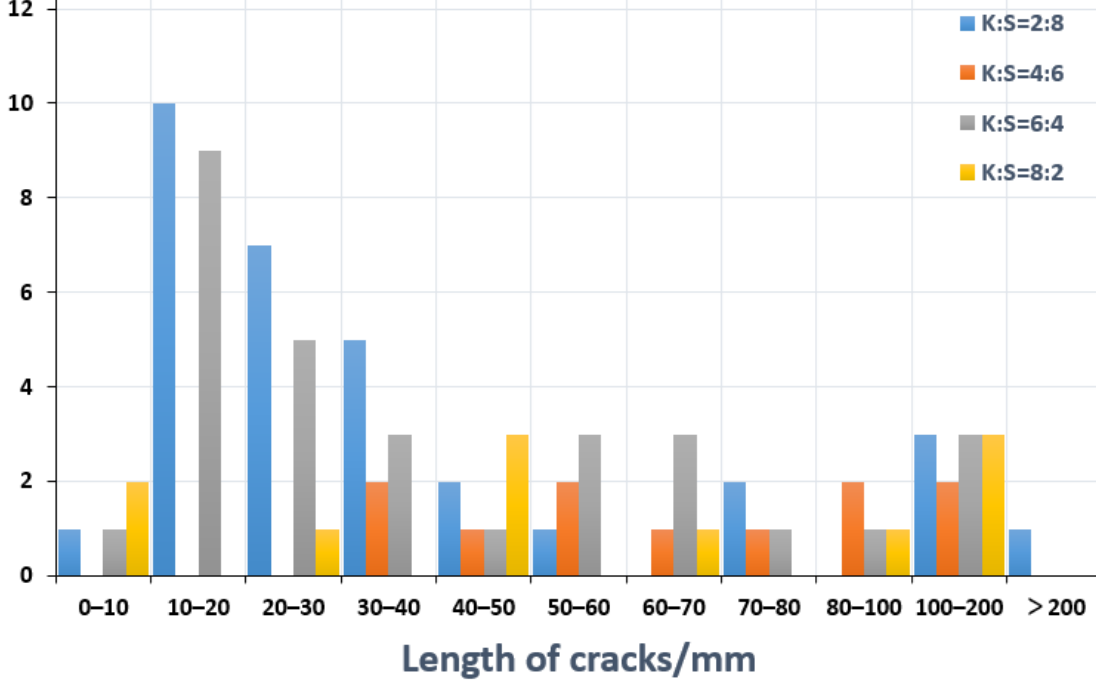
Figure 9. Distribution of crack length in samples with different K:S.